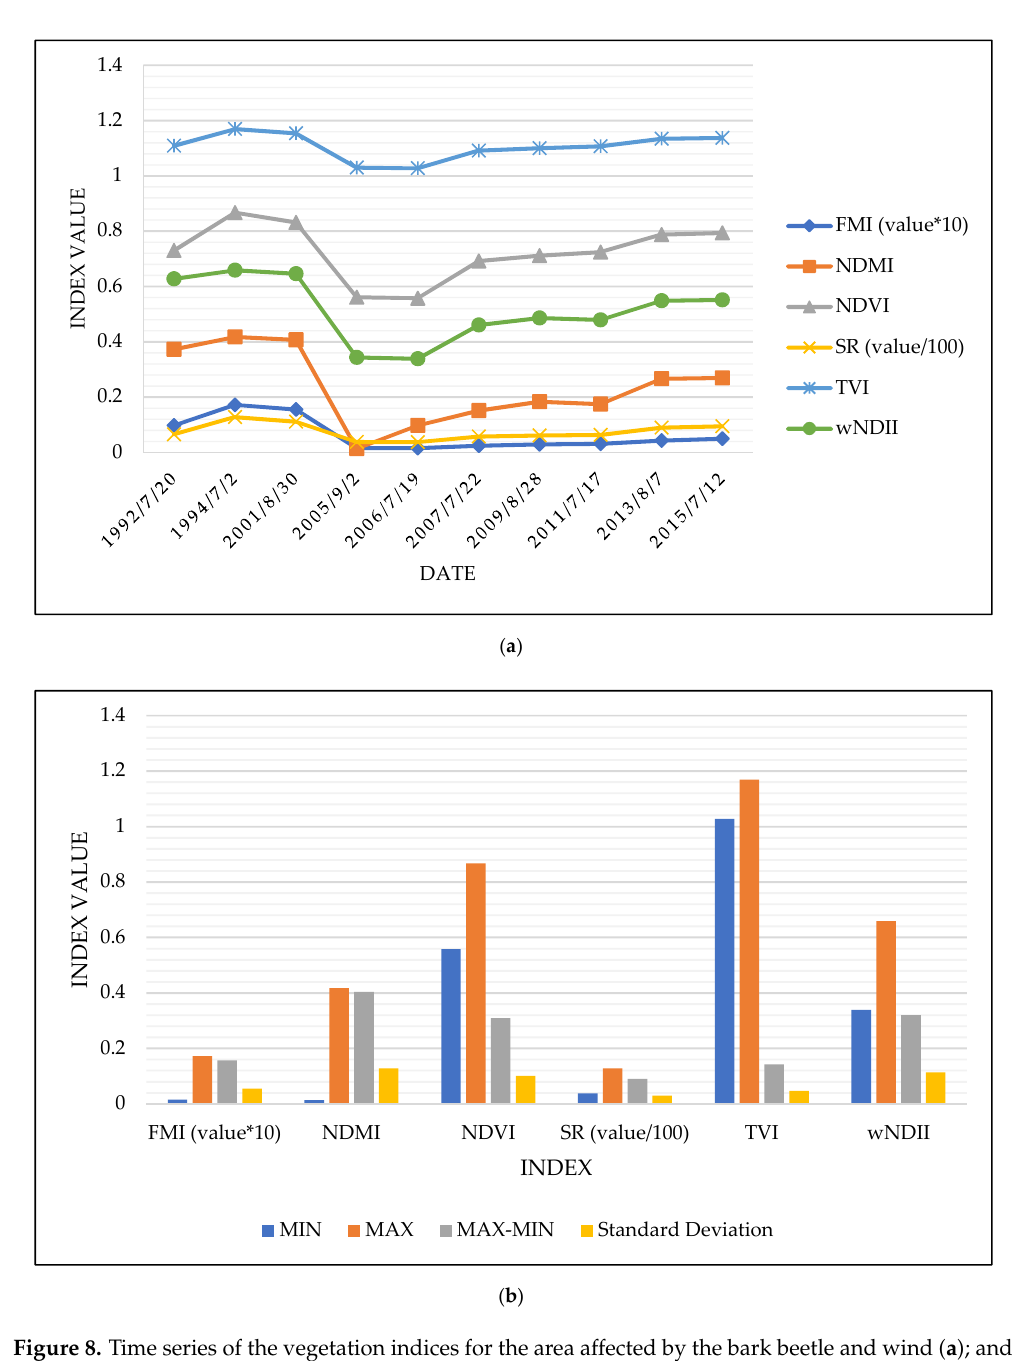
Figure 8. Time series of the vegetation indices for the area affected by the bark beetle and wind ( a ); and the statistical information ( b ) (Locality 4) (Source: Own work).